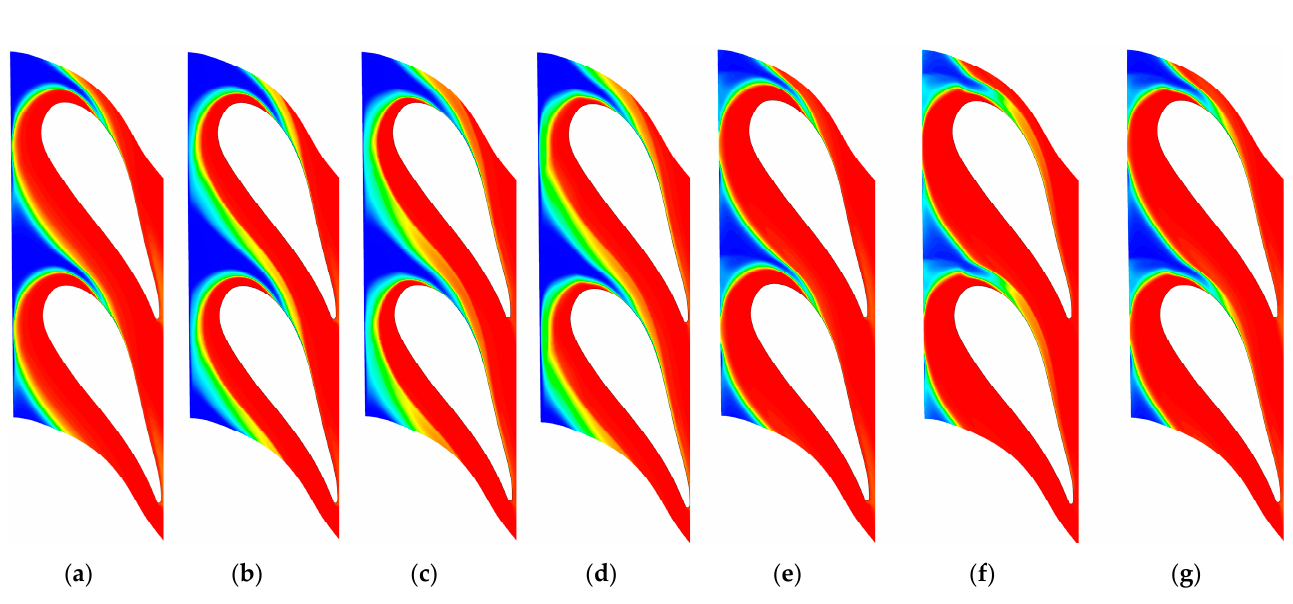
Table 6. The Δ 𝐴 (cid:3032) (cid:3364)(cid:3364)(cid:3364) of different non-axisymmetric endwalls with variable Slotting angles .